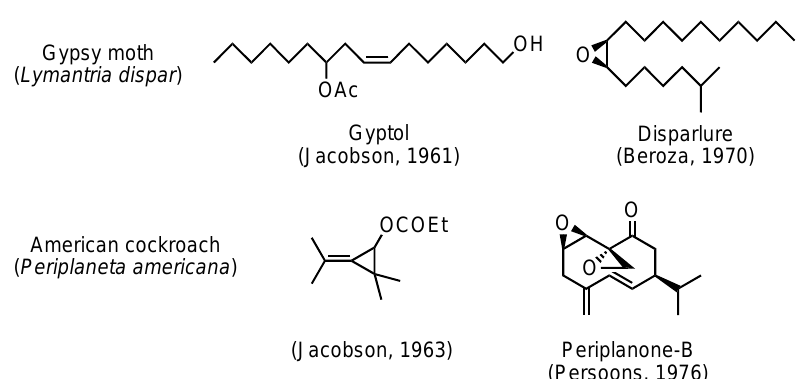
Examples of Wrong and Correct Structures Proposed for